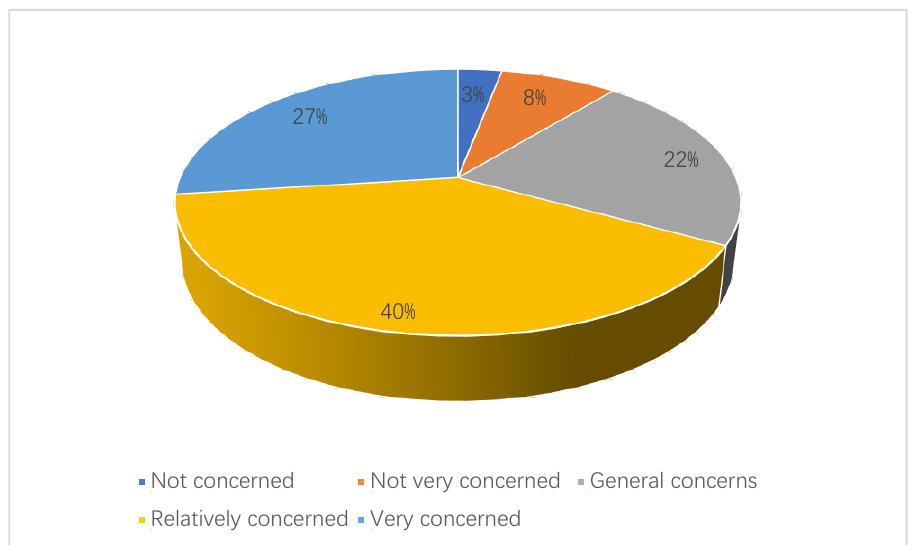
Figure 10. Consumers’ attention to food safety.